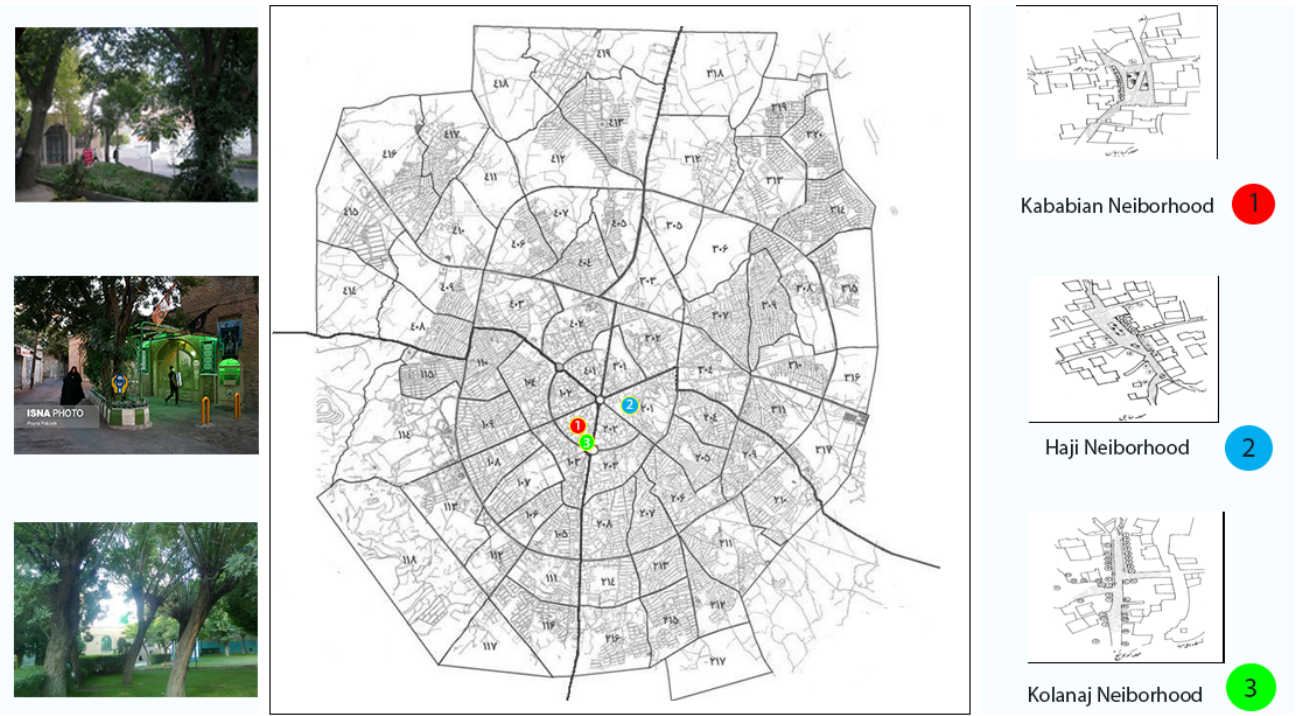
Figure 1. Position of the desired sites .